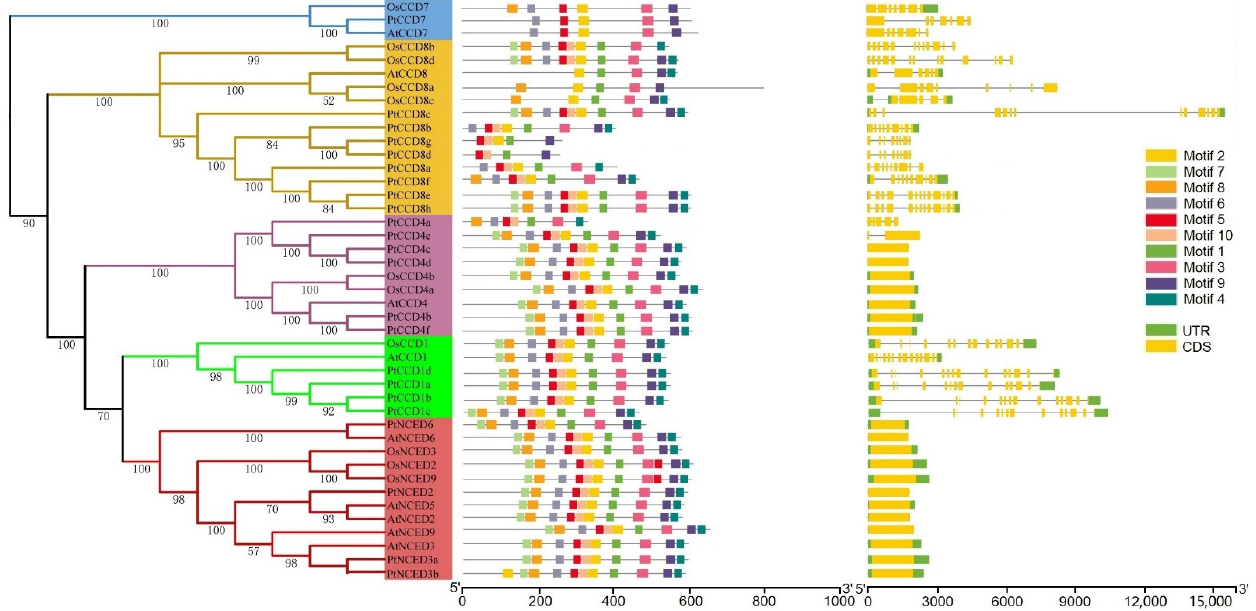
Figure 2. The poplar, Arabidopsis, and rice CCD gene structures and conserved motifs. Exons and introns were represented using bars and rectangles, respectively. The conserved motifs were displayed using colorful rectangles.